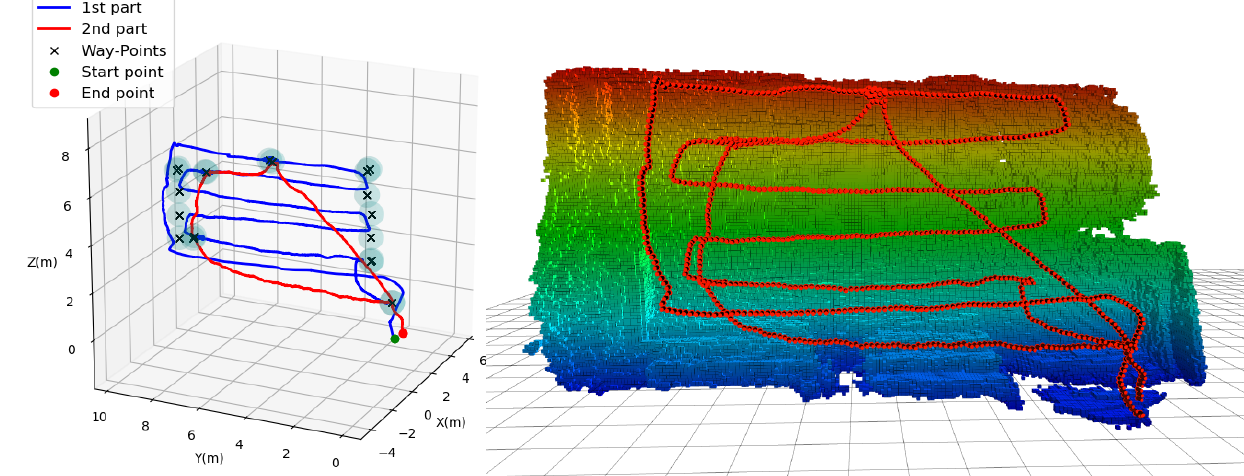
Figure 18. ( left ) Sweeping operation (blue path) followed by way-point re-visitation (red path). ( right ) Occupancy grid to show the coverage achieved. (All units are in